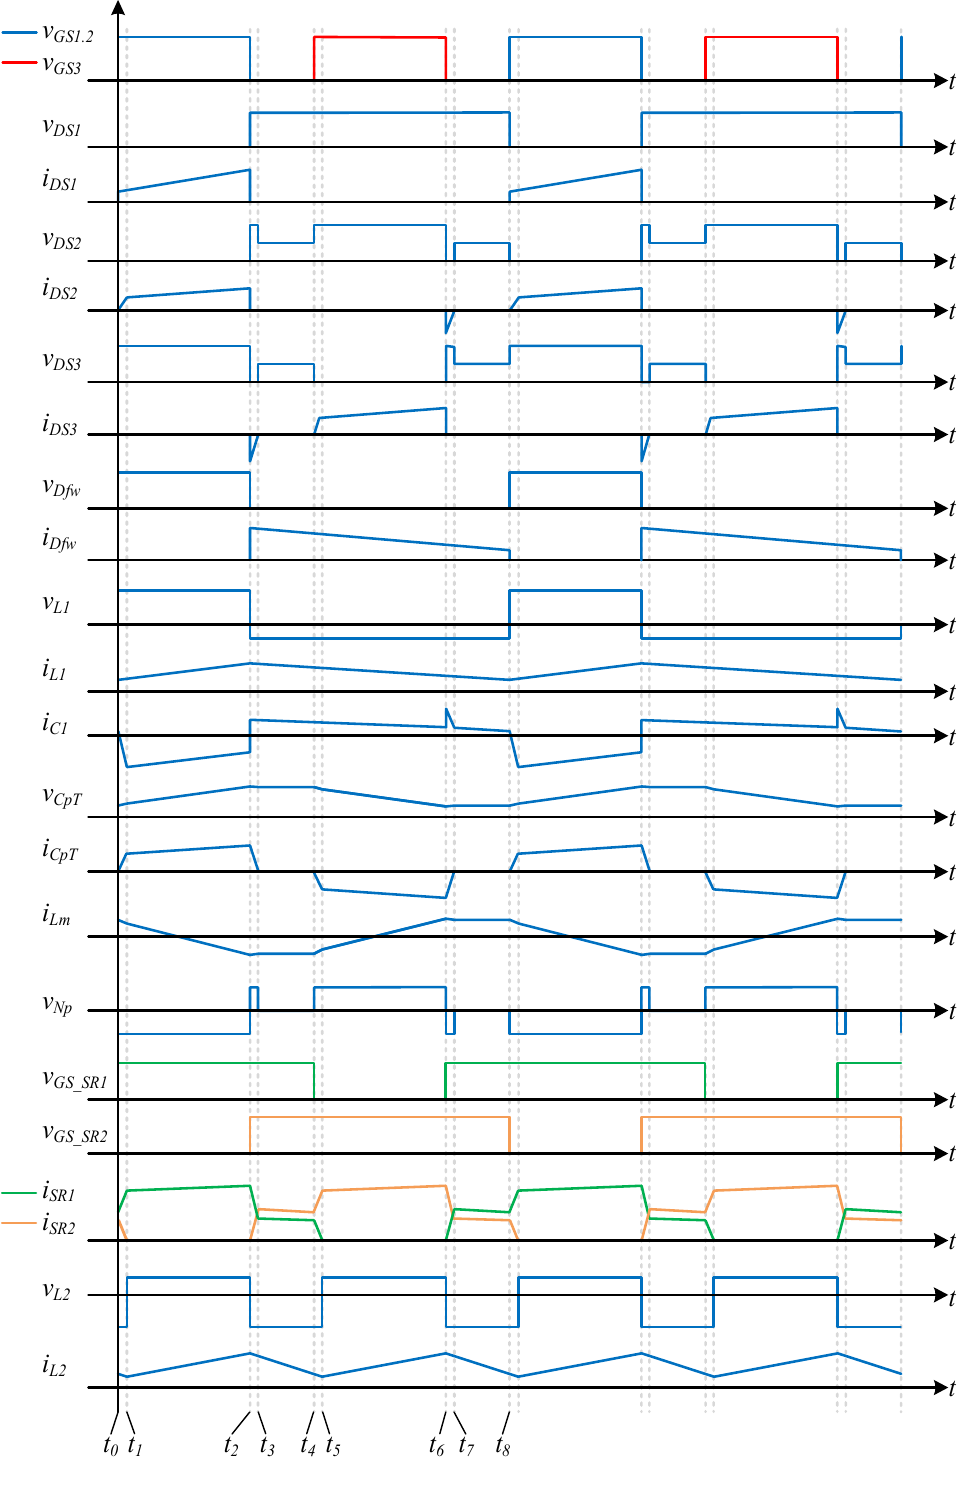
Figure 4. Transient-state waveforms of the proposed IBAHB in CCM. Mode 1 [ t 0 ~ t 1